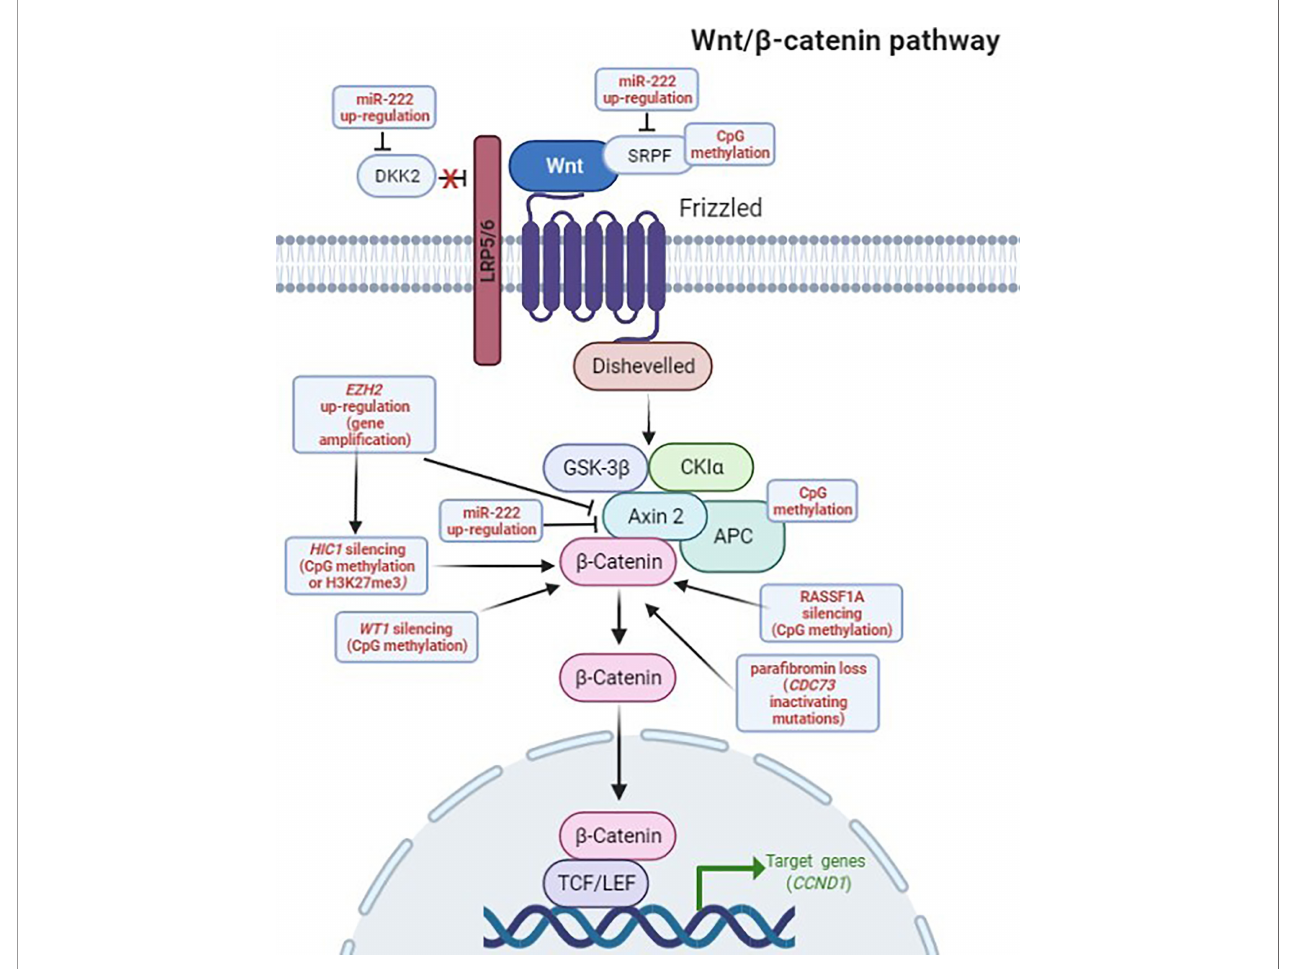
FIGURE 2 | Deregulation of the Wnt/ b -catenin signaling in PCs. Genetic and epigenetic aberrations detected in PC, altering the Wnt/ b -catenin pathway, are highlighted in red. In the canonical Wnt/ b -catenin pathway, the Wnt ligands initiate signaling by interacting, on the cell surface, with the Frizzled (FZD) receptor and the low density lipoprotein receptor-related protein 5/6 (LRP5/6) coreceptor. The ligand-activated FZD-LRP5/6 complex recruits, respectively, Dishevelled and AXIN2 intracellular proteins, preventing the constitutive destruction of cytosolic b -catenin by disassembling the b -catenin destruction complex, consisting of AXIN2, adenomatous polyposis coli (APC), glycogen synthase kinase3 b (GSK3 b ) and casein kinase 1 (CK1), and ultimately leading to active b -catenin accumulation and nuclear translocation. In the nucleus, b -catenin binds and activates transcription factors of the lymphoid enhancer-binding factor (LEF)/T-cell factor (TCF) family, leading to the transcription of Wnt target genes (i.e. CCND1 ). DKK2 and SFRP proteins are natural extracellular inhibitors of the Wnt signaling, by respectively binding, and inactivating, the LRP5/6 coreceptor and the Wnt ligands. Figure created in BioRender.com, accessed on 10 January